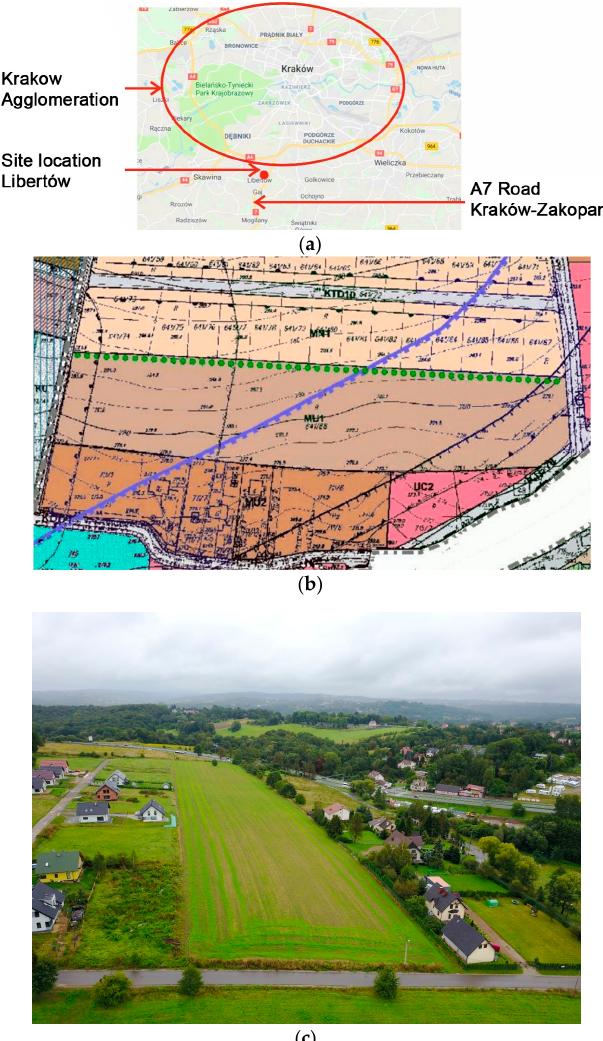
Figure 3. ( a ): Location of the experimental housing complex relative to the Krakow agglomeration; ( b ): Zoning plan of the plot assigned for the construction of the experimental housing complex; ( c ): View of the plot assigned for the construction of the experimental housing complex, as seen from a birds-eye view.